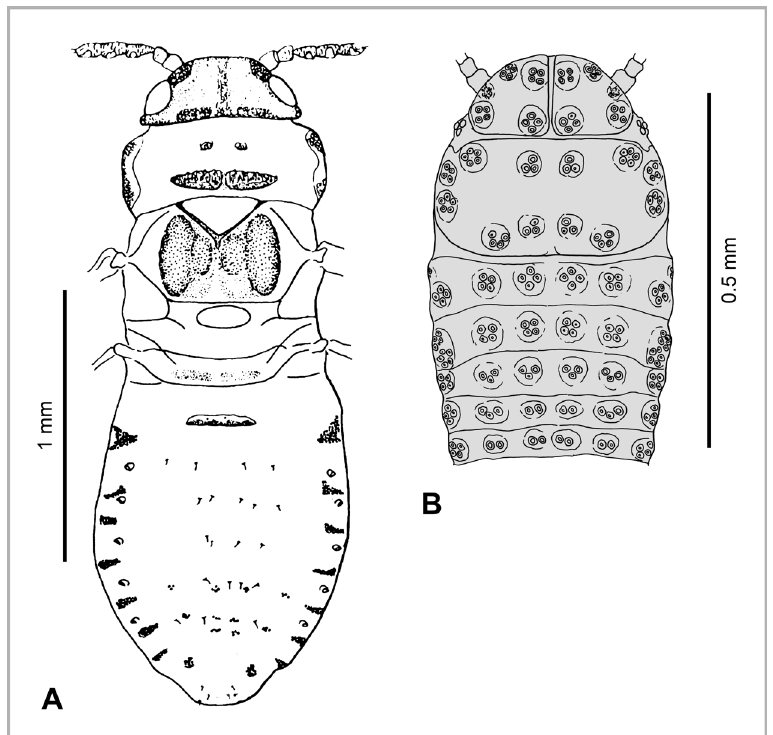
Fig. 57. Adelges (Sacciphantes) viridis (Ratzeburg, 1843). A . Sexupara. Note wax glands on prothorax (absent in gallicola) (after Carter 1971, redrawn from Heie 2004). B . Neosistens (after Schneider-Orelli 1947,